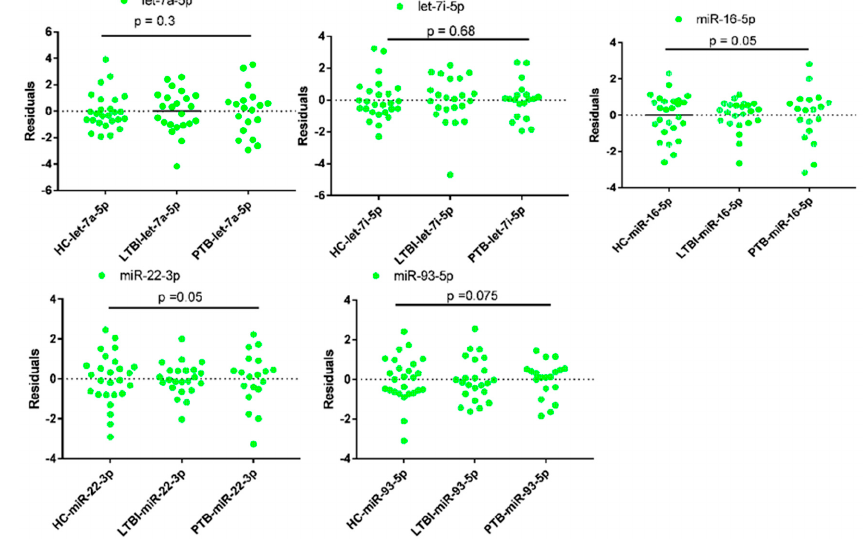
Figure 2. Analysis of variances of qPCR data of candidate reference miRNAs in plasma of tuberculosis infected participants and health controls (HC). LTBI = Latent Tuberculosis Infection, PTB = Pulmonary tuberculosis, where p < 0.05 considered as statistically significant. LTBI = 23, PTB= 19 and HC = 26.